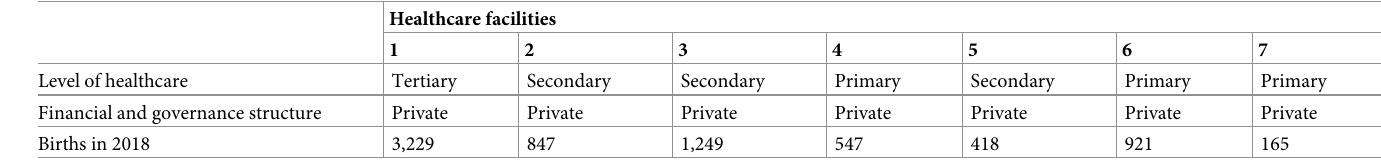
Table 1. Level, governance, and number of births at each healthcare